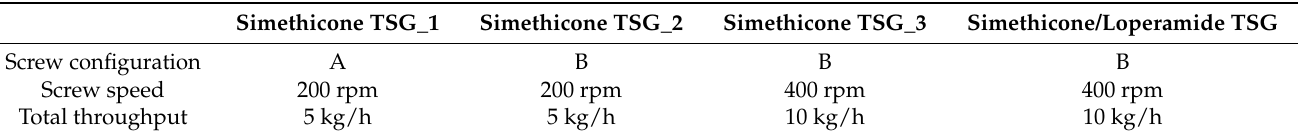
Table 3. Various TSG process parameters.